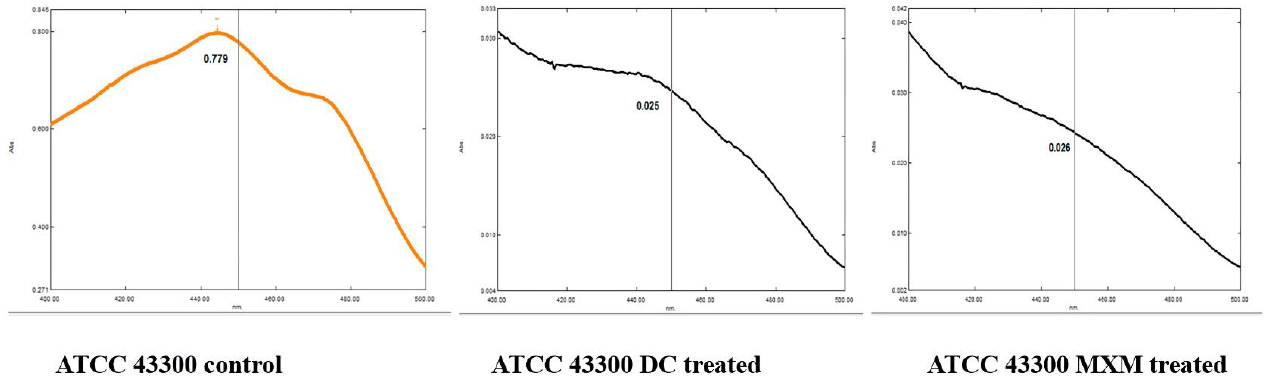
Figure 5. Absorbance spectra of STX extracted from standard strain MRSA before and after DC/MXM treatment.